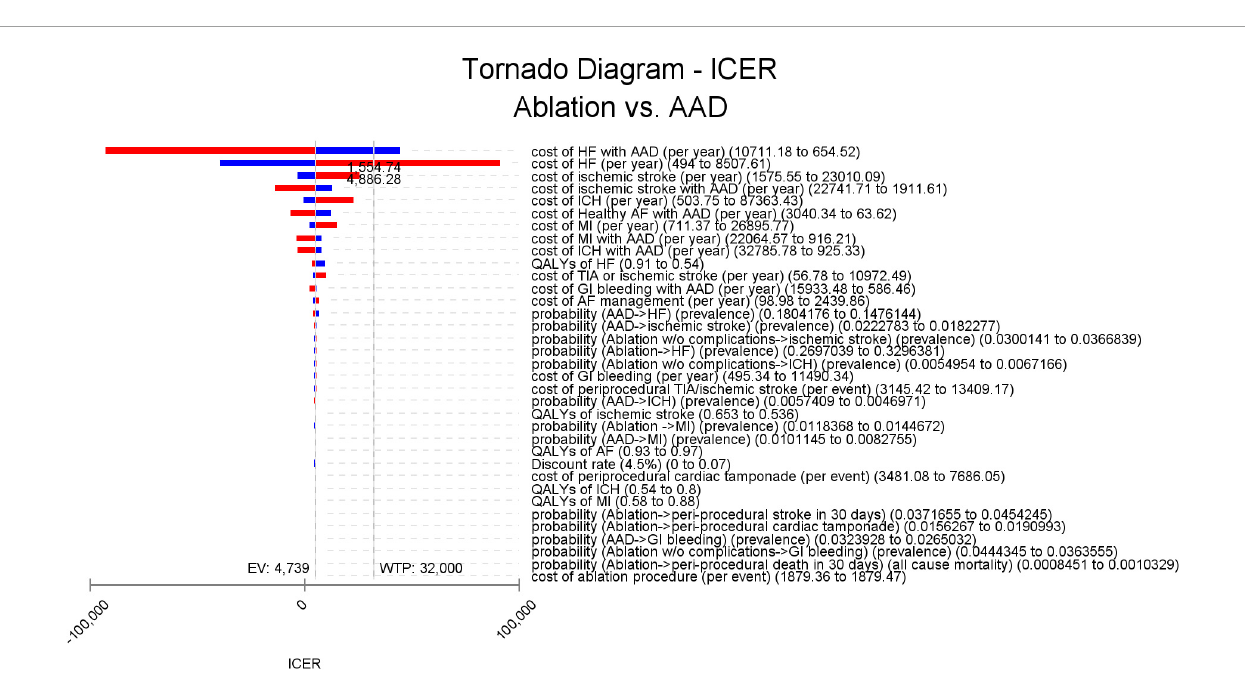
ablation compared with AADs were below the WTP by